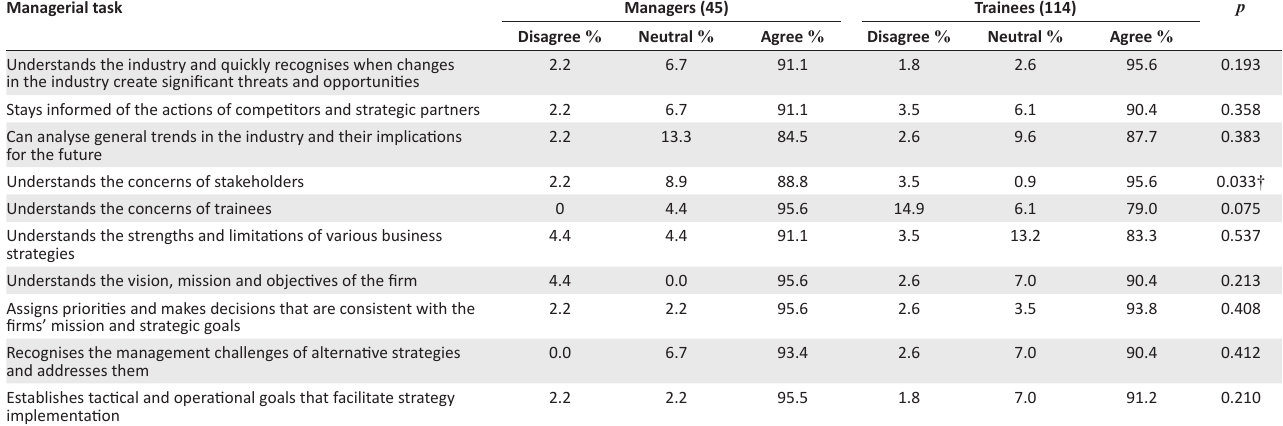
TABLE 7: Results for strategic action. Managerial task